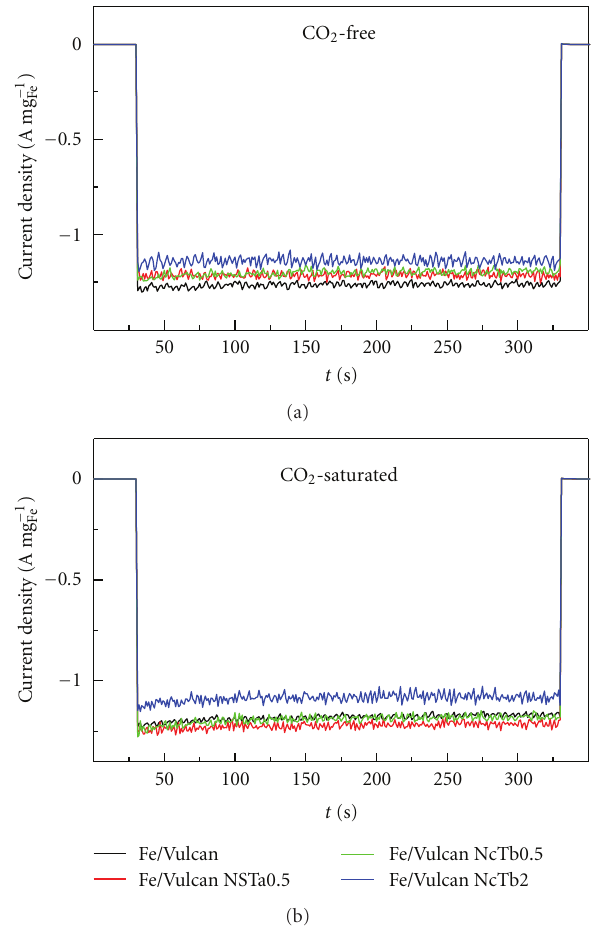
Figure 5: CTs for CO 2 -free (a) and CO 2 -saturated (b) solution in 0.5M H 2 SO 4 on Fe/C catalysts ( E i = − 0 . 2 V, E f = − 1 . 8 versus